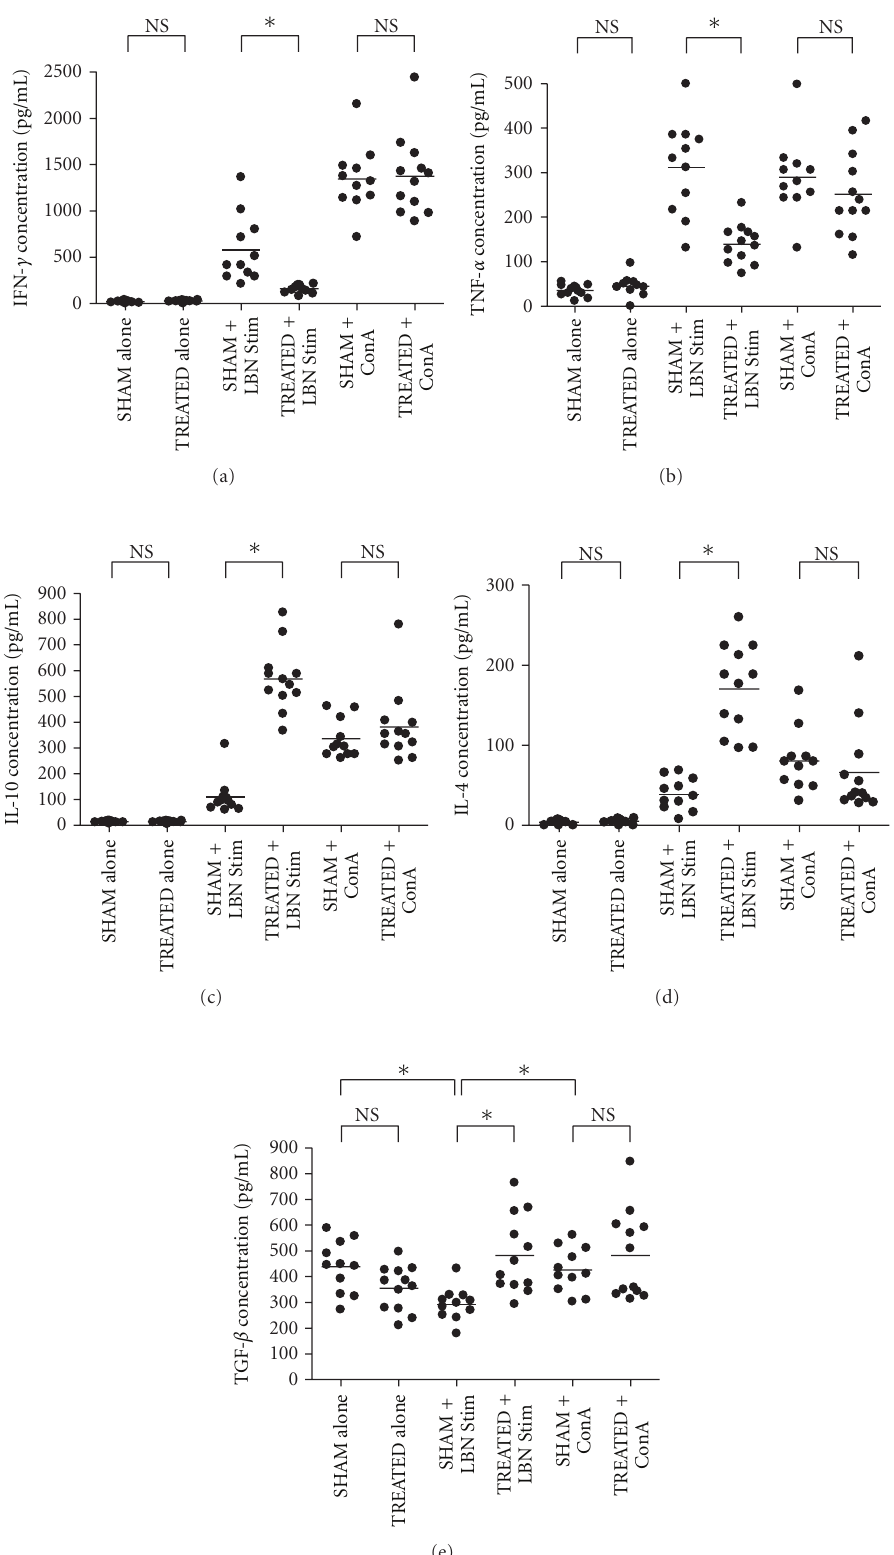
Figure 4: Cytokine concentrations in one-way MLR supernatants according to flow cytometric bead arrays ((a) IFN- γ ; (b) TNF- α ; (c) IL-10; (d) IL-4) and ELISA ((e) TGF- β ) presented as scatter plots with mean bar. “ ∗ ” P < 0 . 05; “NS” P < 0 . 05 (specific P values provided in the